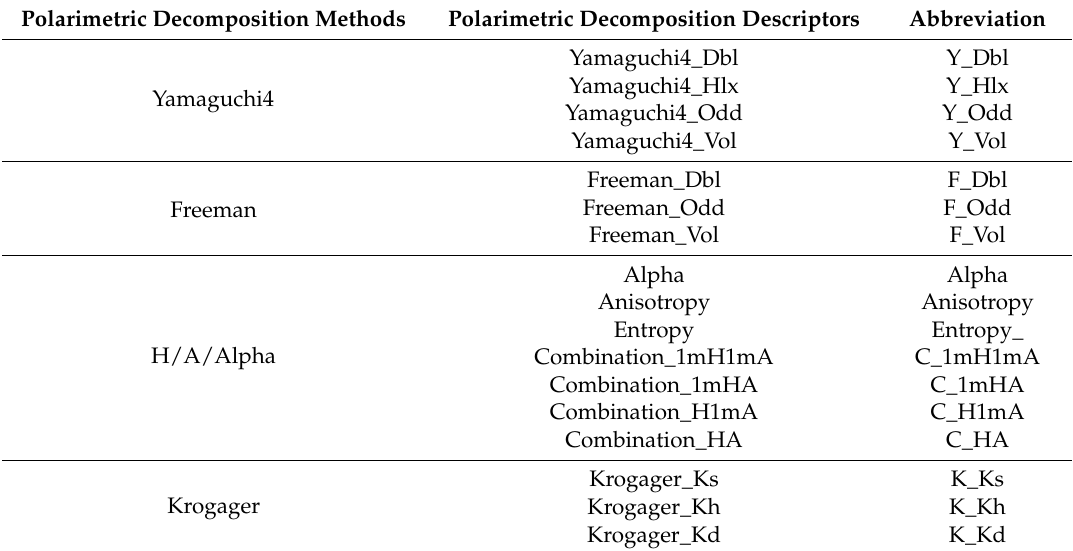
Table 3. The polarimetric decomposition descriptors extracted from Radarsat-2